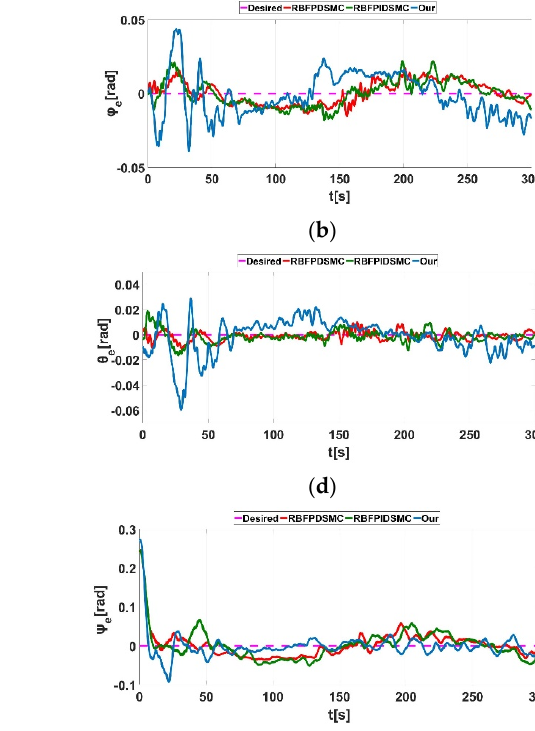
. Figure 12. AUV position − tracking errors. ( a ) x 𝑒